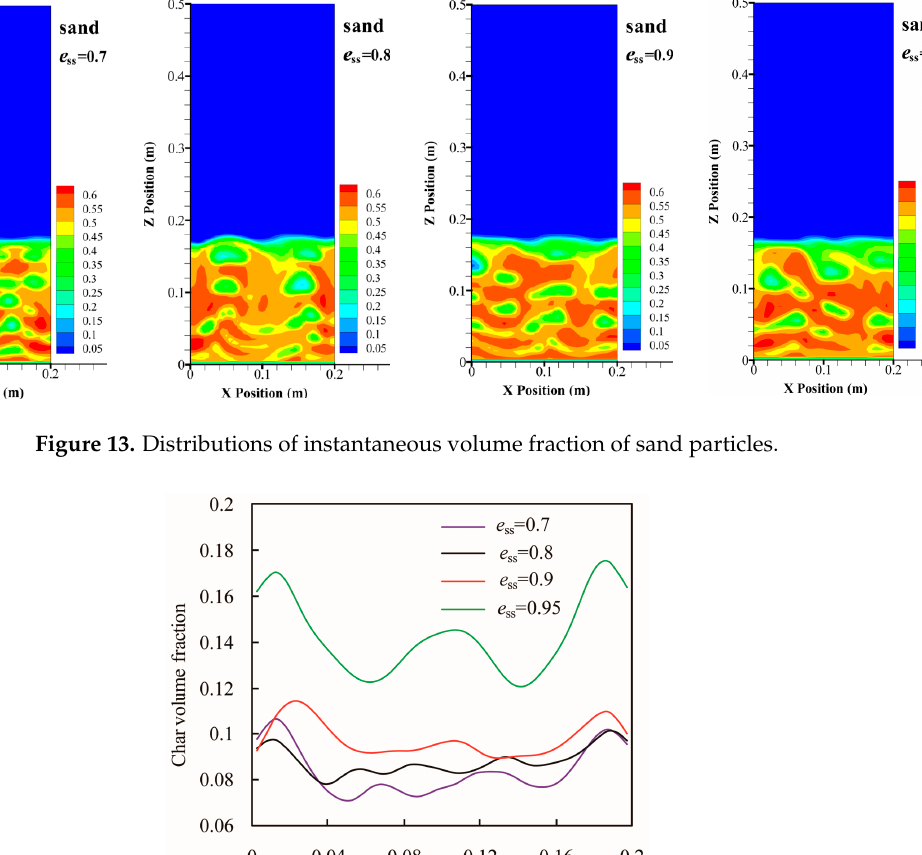
Figure 12. Distributions of instantaneous volume fraction of char particles.